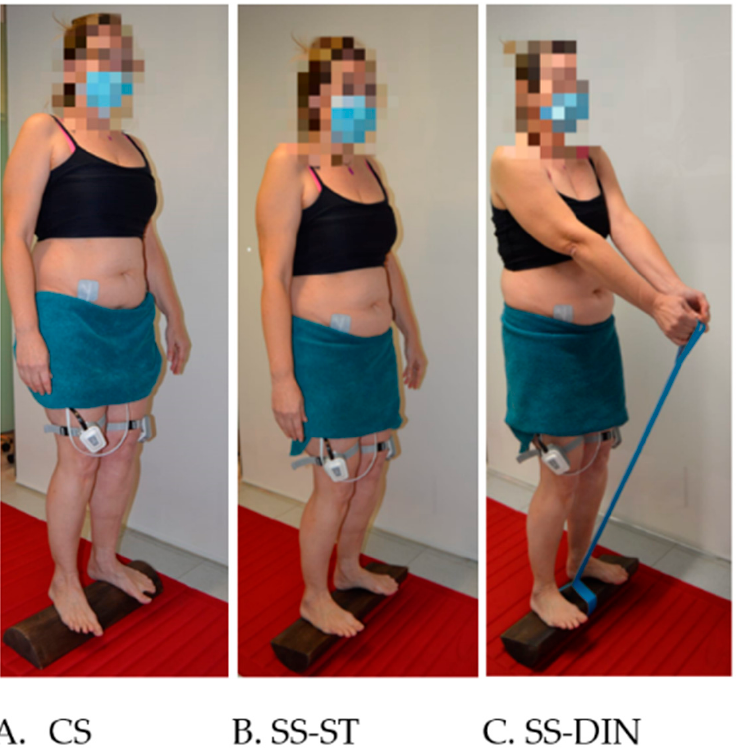
Figure 1. ( A ). Static phase on the convex side of the oak wood surface (CS); ( B ). Static phase on the the surf side of the oak wood surface (SS-ST); ( C ). Dynamic phase on the surf side of the oak wood surf side of the oak wood surface (SS ‐ ST); ( C ). Dynamic phase on the surf side of the oak wood surface performing exercises with elastic resistance band surface performing exercises with elastic resistance band (SS ‐ DIN).